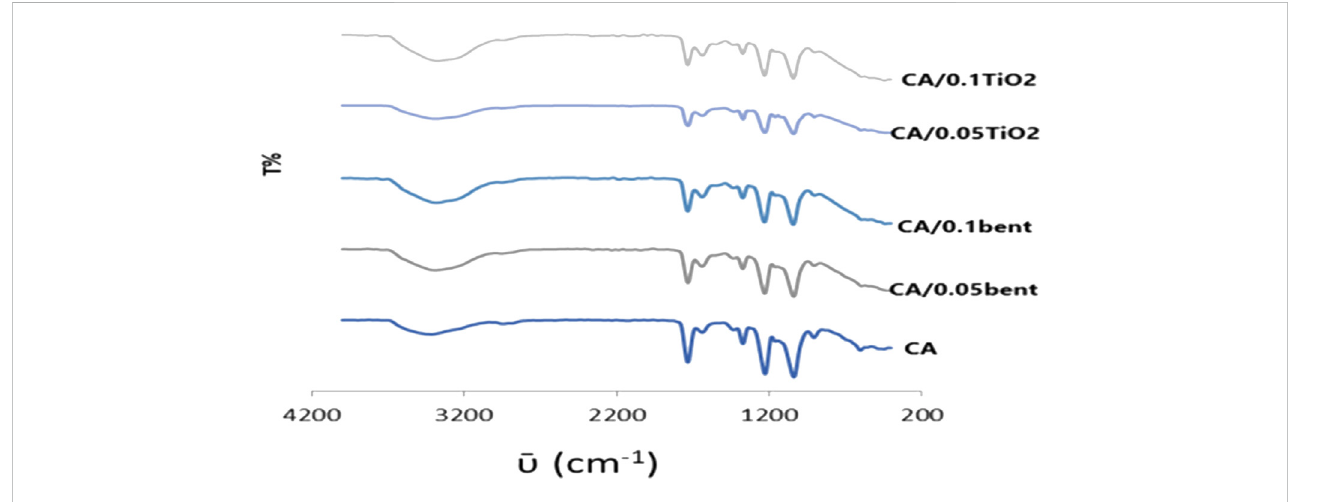
FIGURE 1 FTIR of prepared cellulose acetate nanocomposite